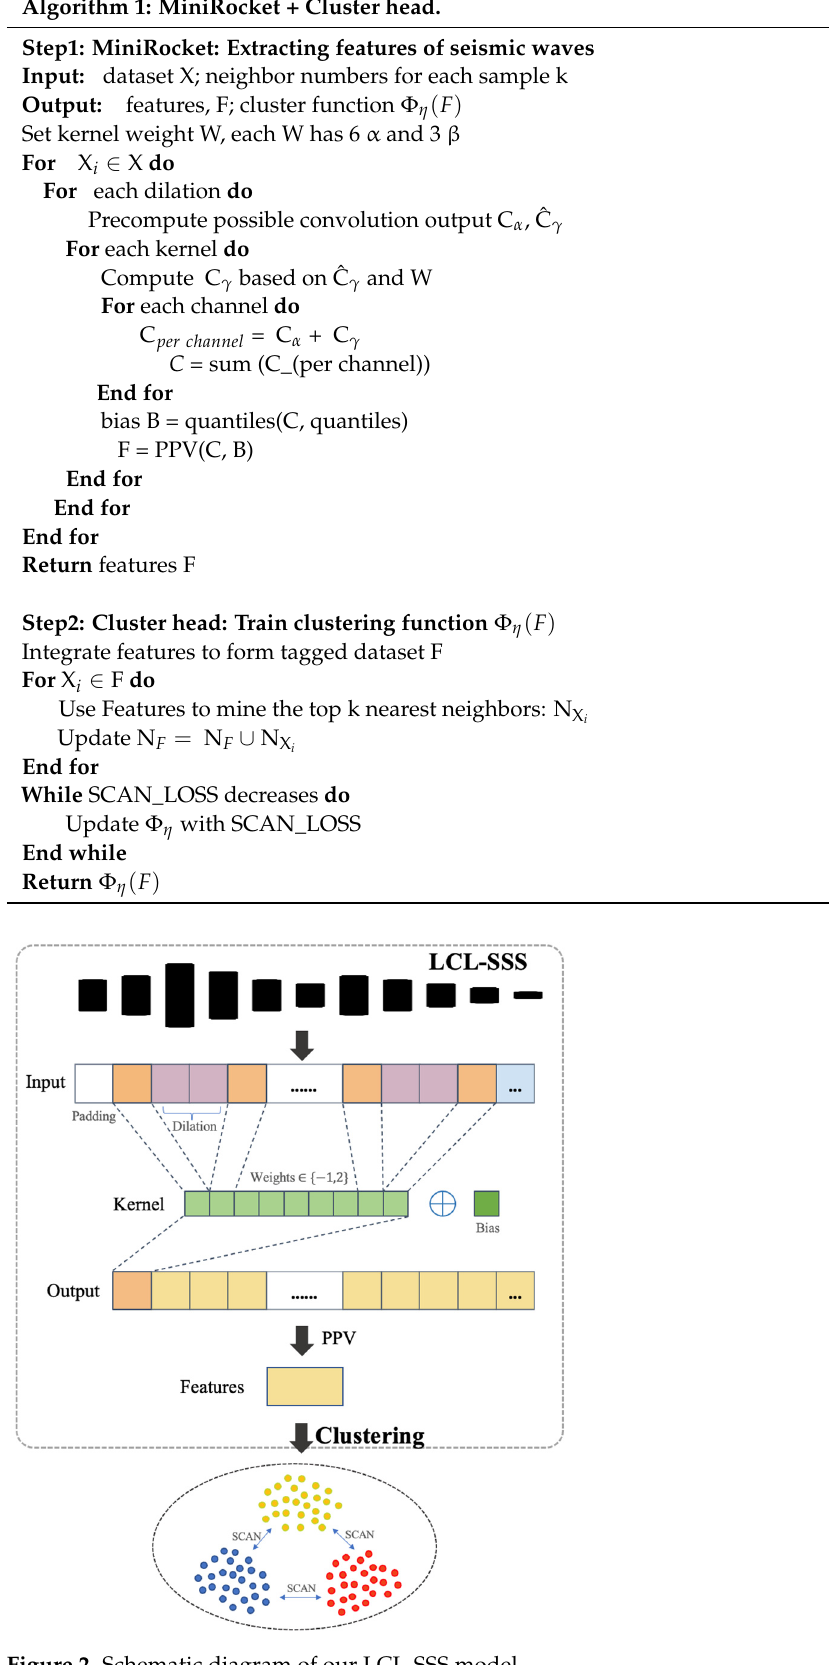
Figure 2. Schematic diagram of our LCL-SSS model.